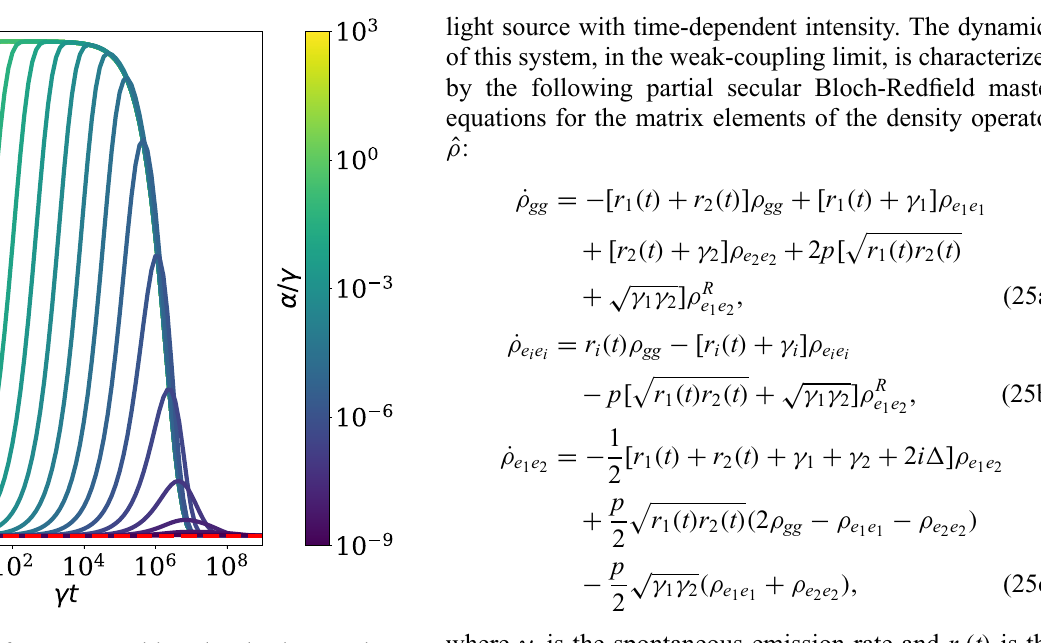
FIG. 2. Dynamics of a V system driven by slowly turned on incoherent light. The intensity of the exciting field, i.e., the mean photon number, turns on with a rate α following an exponential activation function n ( t ) ∝ [1 − exp ( − α t ) ]. We consider a system driven by a blackbody source with temperature T = 5800 K with ground to excited state excitation energy of ω ge = 1.98 eV. Both excited states have a natural line width of γ = 1 GHz with a splitting of (cid:15) = 0.001 (cid:2) γ . The yellow to blue traces show the dynamics under a range of turn-on rates while the dashed red trace shows the adiabatic turn-on